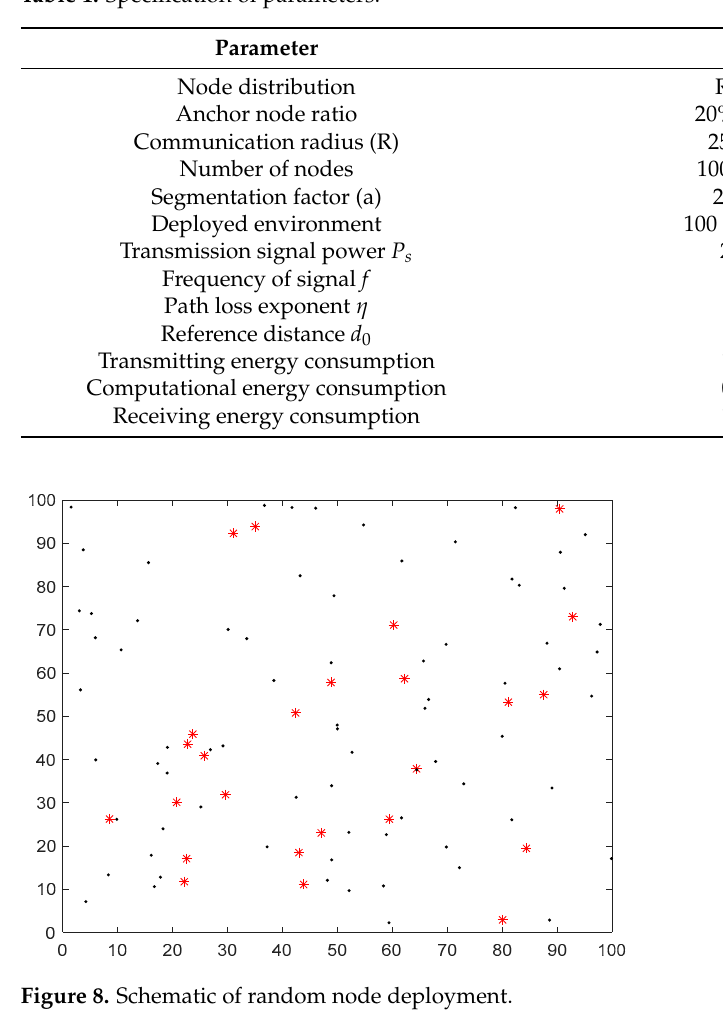
Table 1. Specification of parameters.